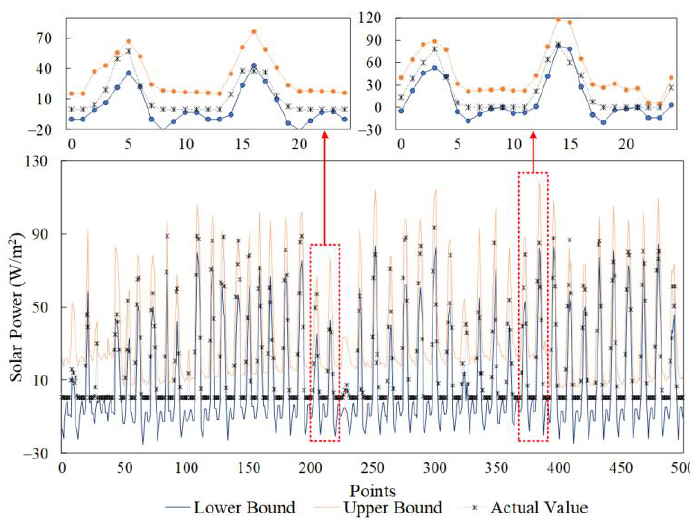
Figure 14. The prediction result obtained by HS and WI w/o ELM-AE. Table 6. Average computational time (s) for di ff erent initialization approaches with ELM-AE. Algorithms